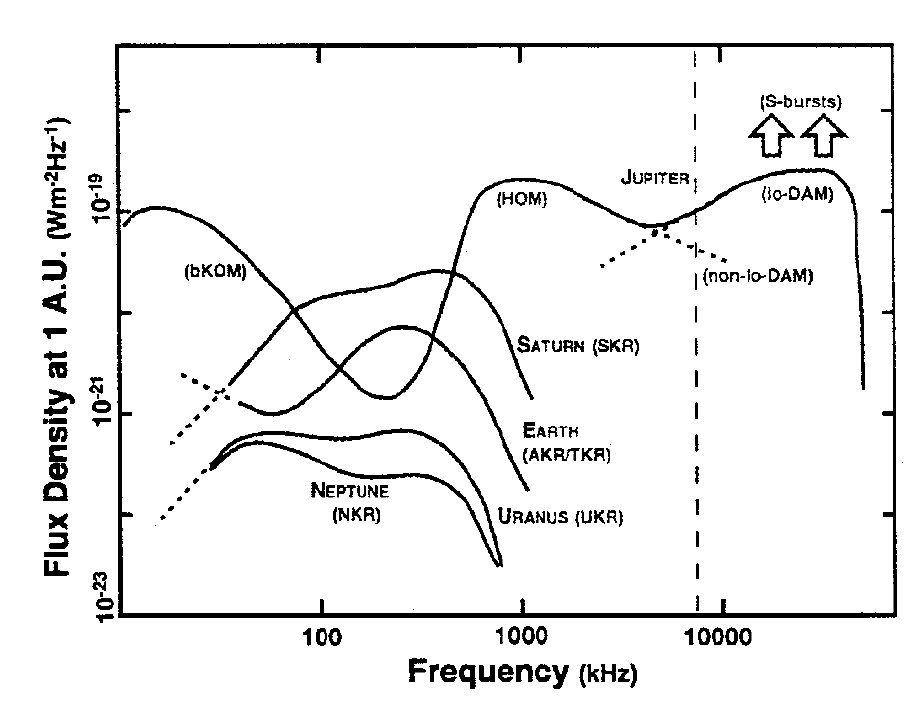
Figure 7. The radio spectra observed at Jupiter, Saturn, Earth, Uranus, and Neptune [43]. The Magnetospheric Imaging Instrument (MIMI) on Cassini provided a form of remote sensing of Saturn’s magnetosphere not available for the other outer planets. The coexistence of trapped energetic ions and neutral gases in Saturn’s magnetosphere allows the process of charge exchange to take place, in which an energetic particle takes an electron from a neutral particle, turning the ion into a neutral particle that is no longer magnetically trapped. The neutral particles can be imaged, providing a picture of the source energetic ion population, in a process called Energetic Neutral Atom (ENA) imaging. The Ion and Neutral Camera (INCA), was part of Cassini’s MIMI package. The INCA camera data are available from the PDS (Table 3), including processed images and movies of the ENA that are included as browse files. In Figure 8, we show a sequence of four ENA images in the magnetosphere along with auroral EUV images in the ionosphere. The images show the injection of ions and the corresponding aurora. Note, the images of the ions map along magnetic field lines to Saturn’s aurora and both rotate with